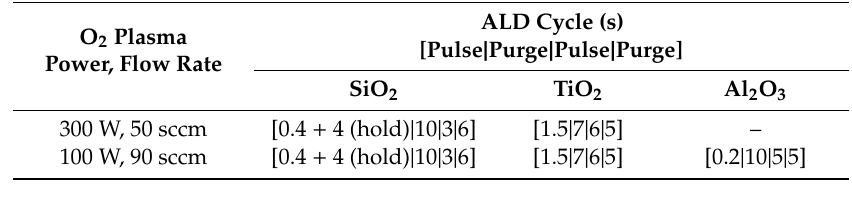
Table 2. Plasma enhanced ALD (PEALD) process parameters at 60 °C.